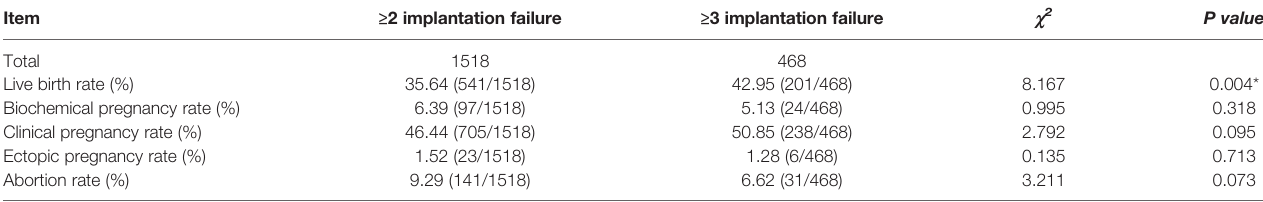
TABLE 4 | Comparison of main pregnancy outcome measures.